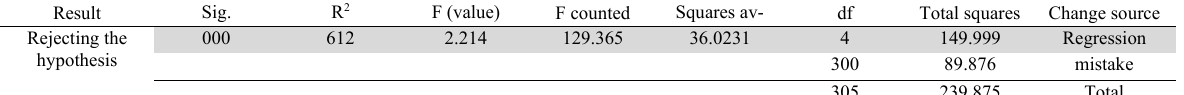
Results of the multiple regression test for the effect of CRM with retaining customers in travel & tourism organizations in Al- Kharj Governorate Result Sig. 2 R F (value) F counted Squares av- df hypothesis